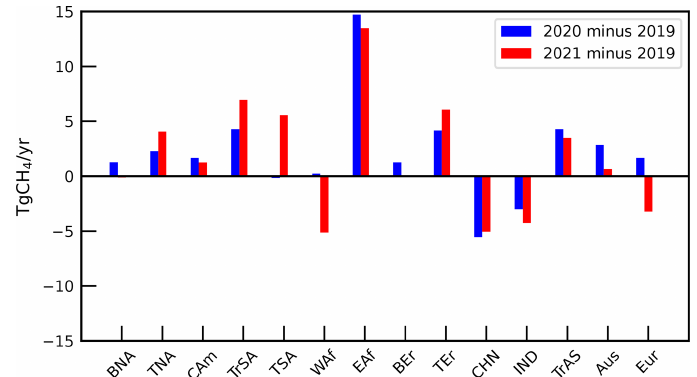
Figure A6. The same as Fig. 1b but for an inversion that uses GOSAT proxy XCH 4 and in situ methane data.